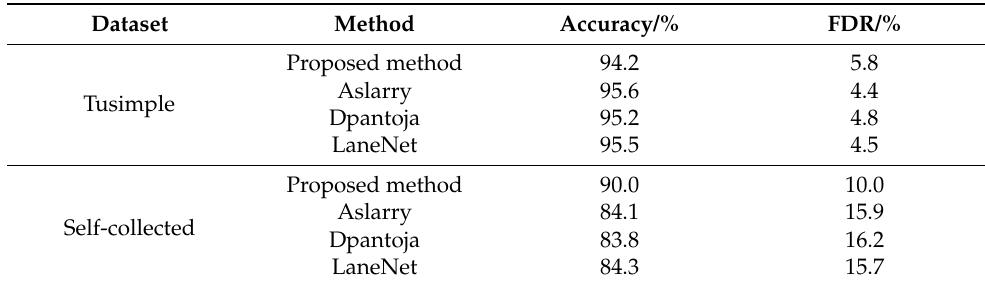
Table 3. Result of lane